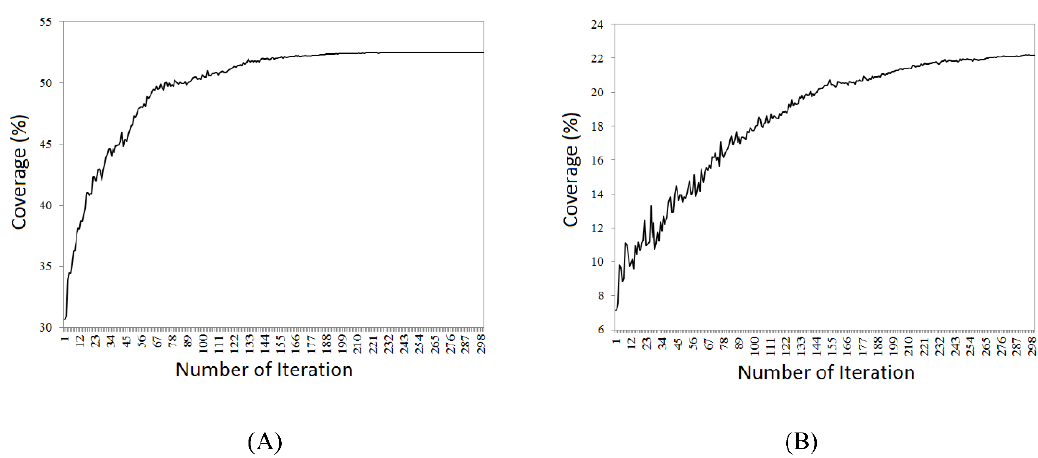
Figure 12. Convergence diagram of probability coverage based on CMAE-ES algorithm for raster models with 100 cm resolution of: ( A ) two-dimensional; and ( B ) three-dimensional.